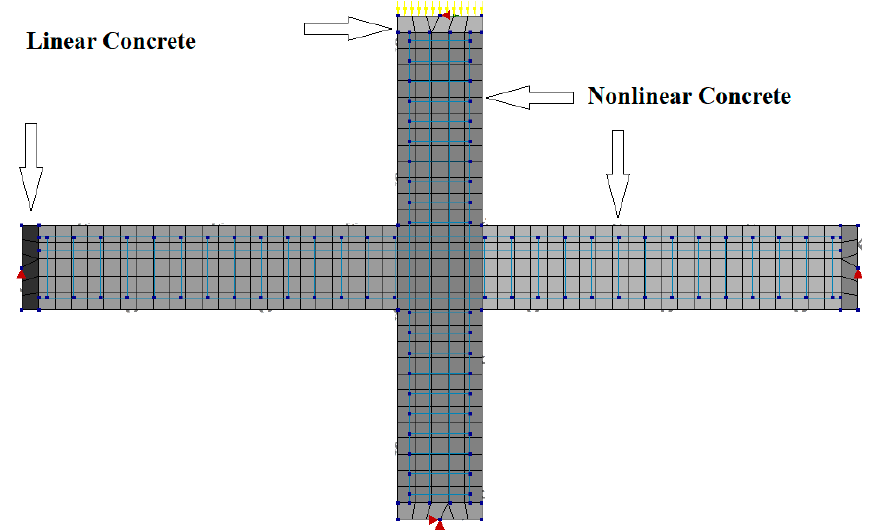
Figure A4. Two-dimensional FE discretization of the Figure A3. Two-dimensional FE discretization of the specimen.